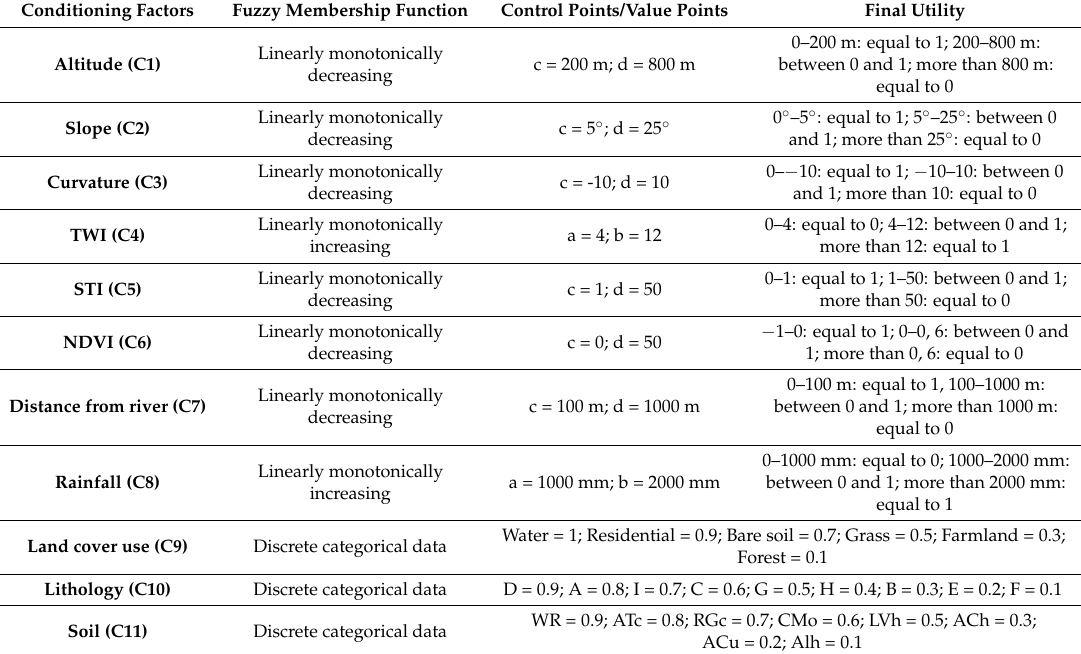
Table 2. Fuzzy standardization of the conditioning